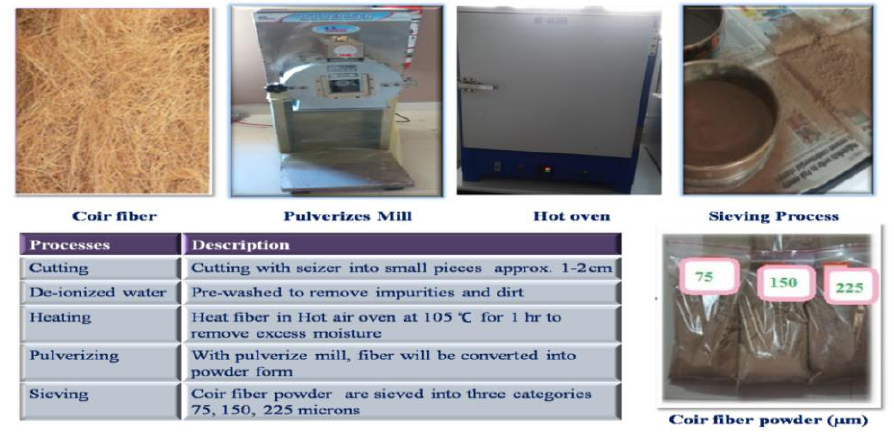
Figure 1. Pulverization process. Table 2. Box–Behnken design with coded/actual values for three-factors of factorial design. Run